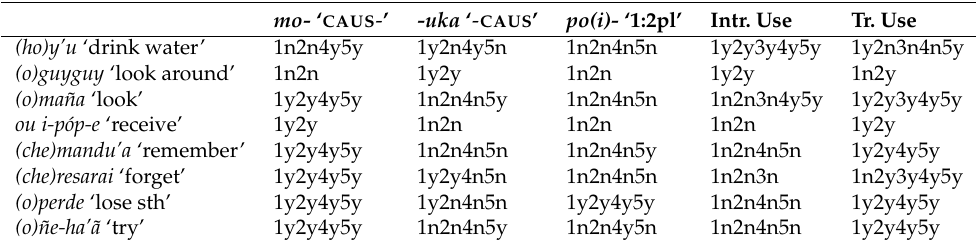
transitive frames. Table A4. Judgments for verbs without a clear